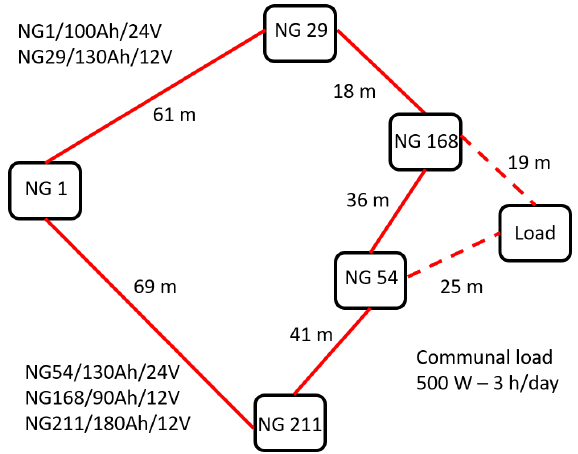
Figure 8. Topology of the simulated